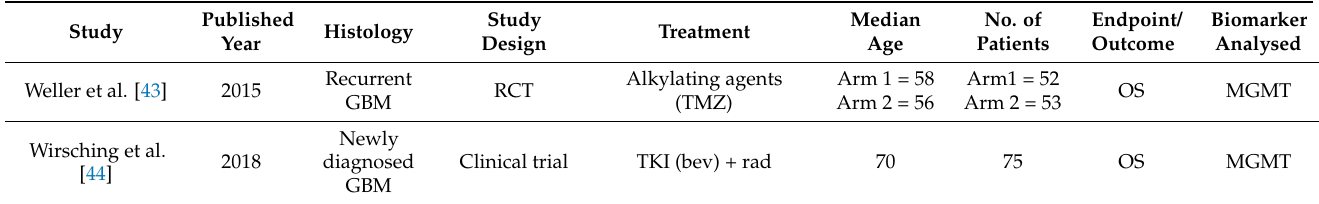
Studies are labelled as the last name of the first author and presented in alphabetical order. Abbreviations: Toca 511 = Vocimagene amiretrorepvector; Toca FC = 5-fluorocytosine; TMZ = Temozolomide, rad = radiation therapy, TKI = Tyrosine kinase inhibitors, bev = bevacizumab, Pla = Placebo, PVC = (procarbazine, CCNU (1-(2- chloroethyl)-3-cyclohexyl-1-nitrosourea) and vincristine, ADCTA = autologous dendritic cell tumour antigen vac- cine, chemoradiotherapy = radiation therapy + chemotherapy with TMZ; R = Retrospective study, P = prospective study, RCT = Randomised control trial, OS = Overall survival; * = mean age; # = mean + STD DEV; N1 = screening